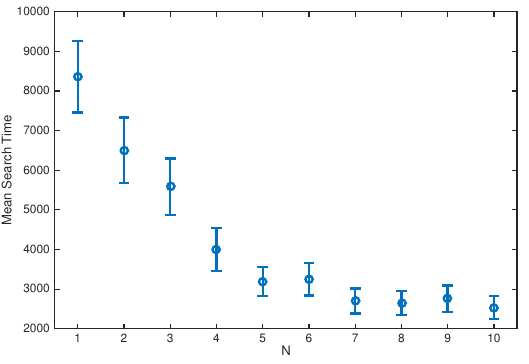
Figure 3. Mean search time when varying the number of platforms, N , from 1 to 10. The error bars show the 95% confidence interval for the estimate of the